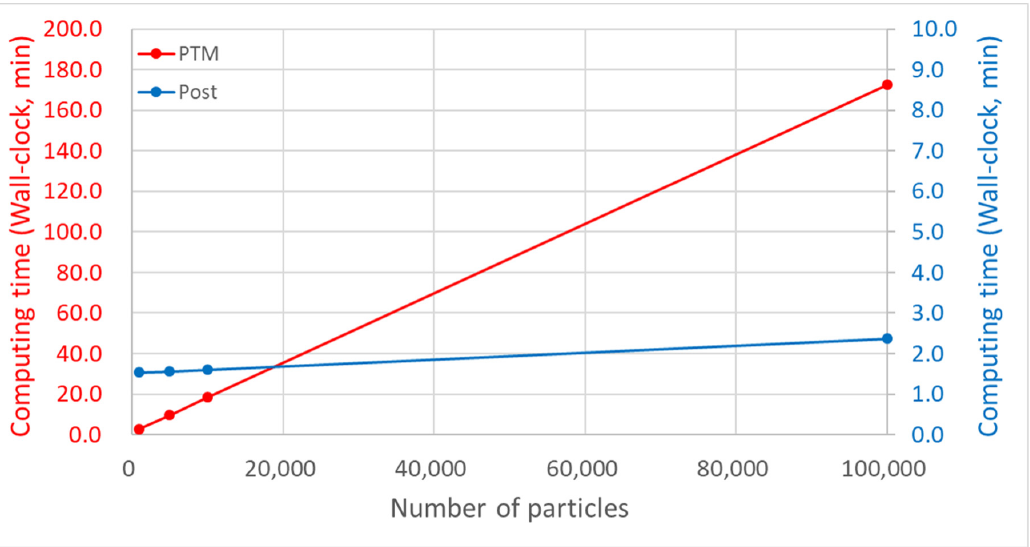
Figure 12. Comparison of CPU time (wall-clock) of particle tracking (red) and postprocessing (blue) for 1 day of simulation in accordance with number of